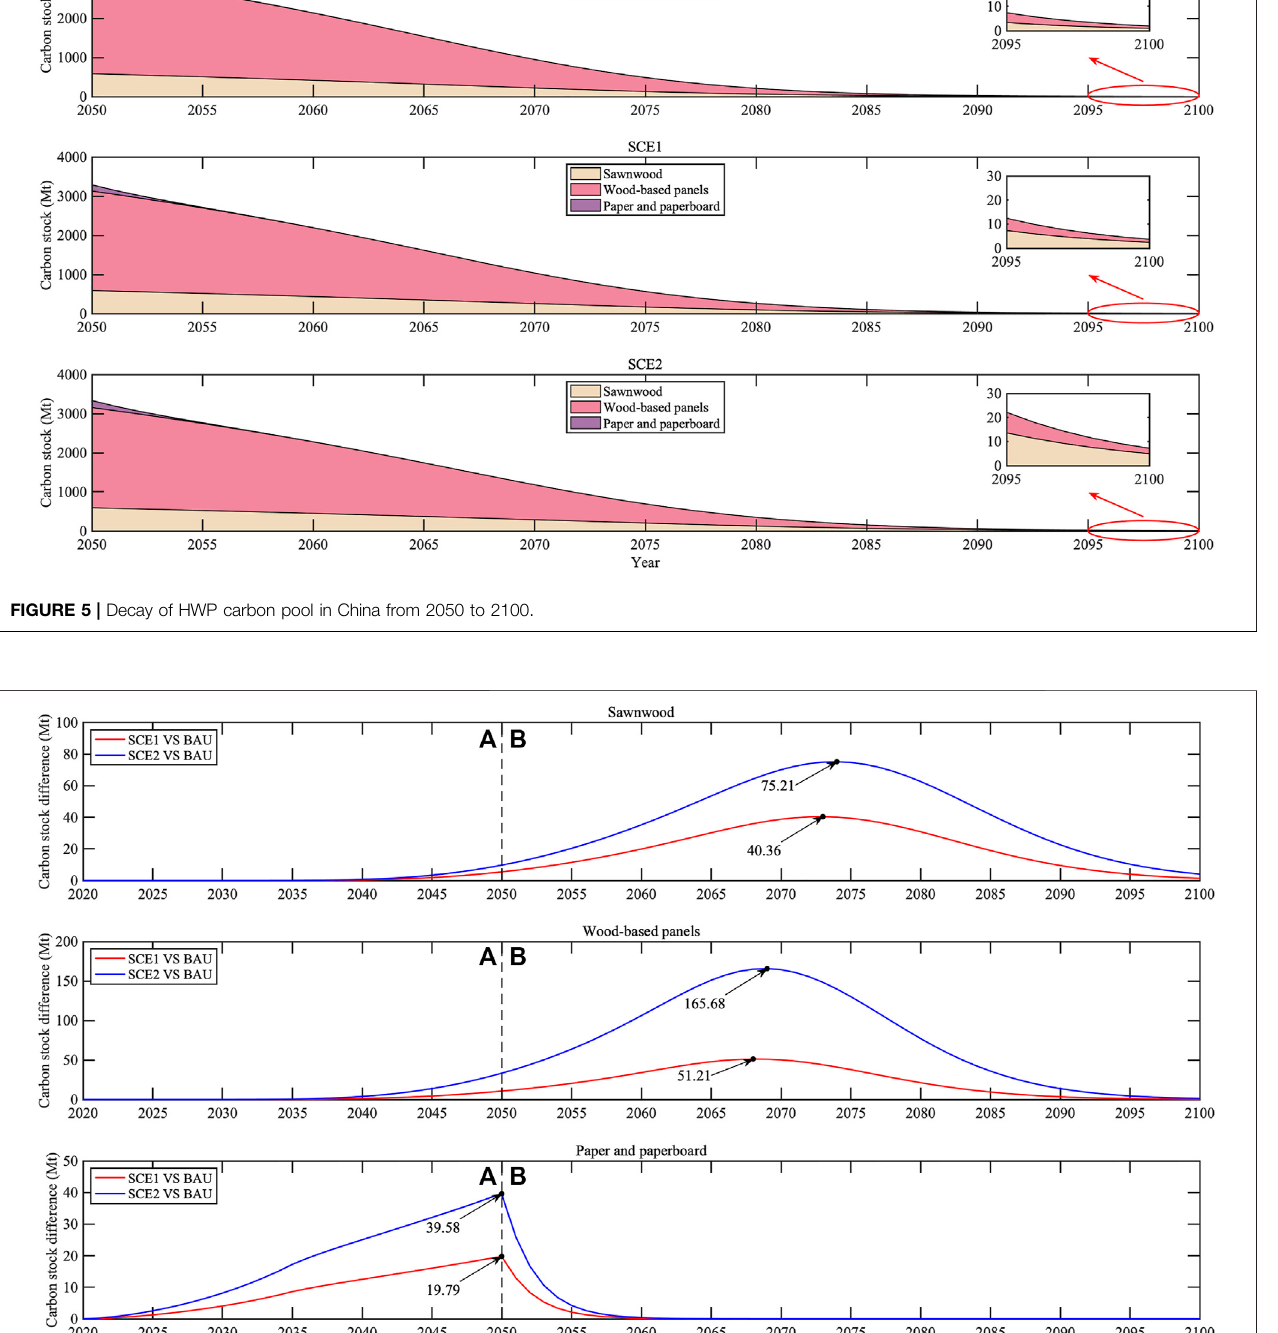
Frontiers in Environmental Science |